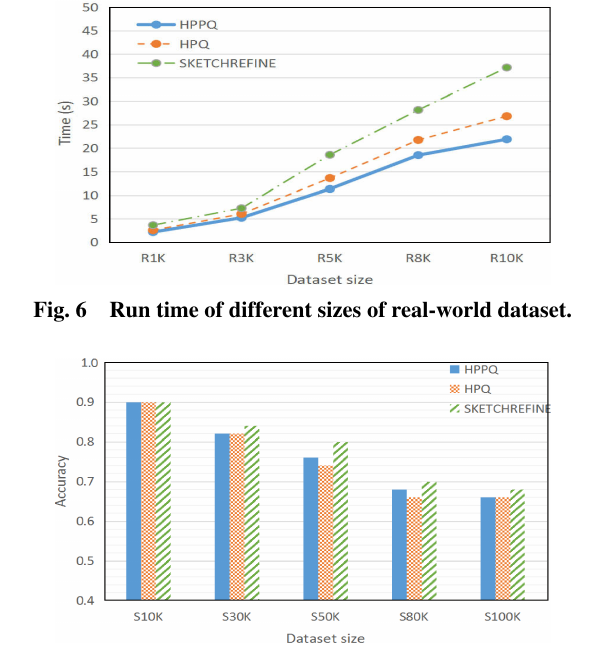
Fig. 7 Accuracy rate of different sizes of synthetic